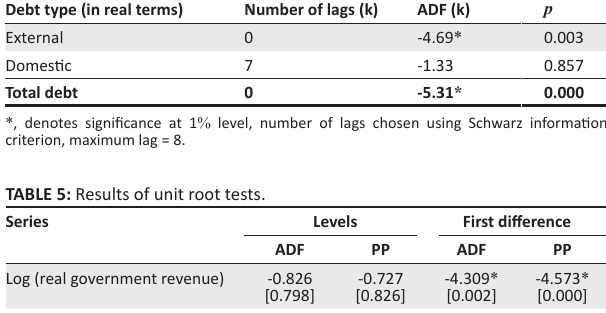
TABLE 4: Test results for ‘no Ponzi scheme’ on real total debt Debt type (in real terms)